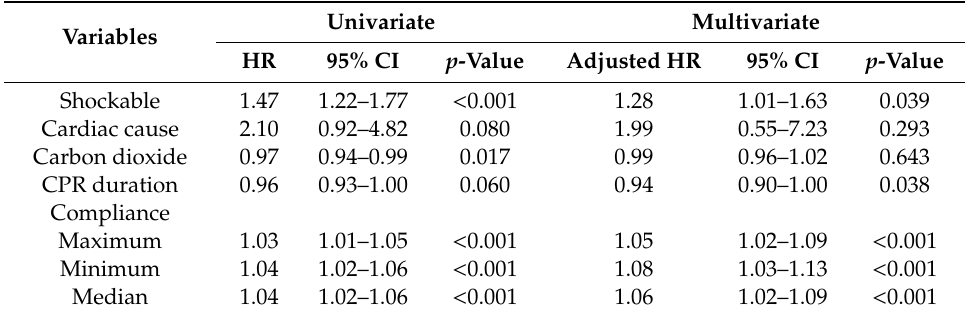
Table 3. Univariate and multivariate time-varying cox regression of lung compliance associated with favorable neurologic